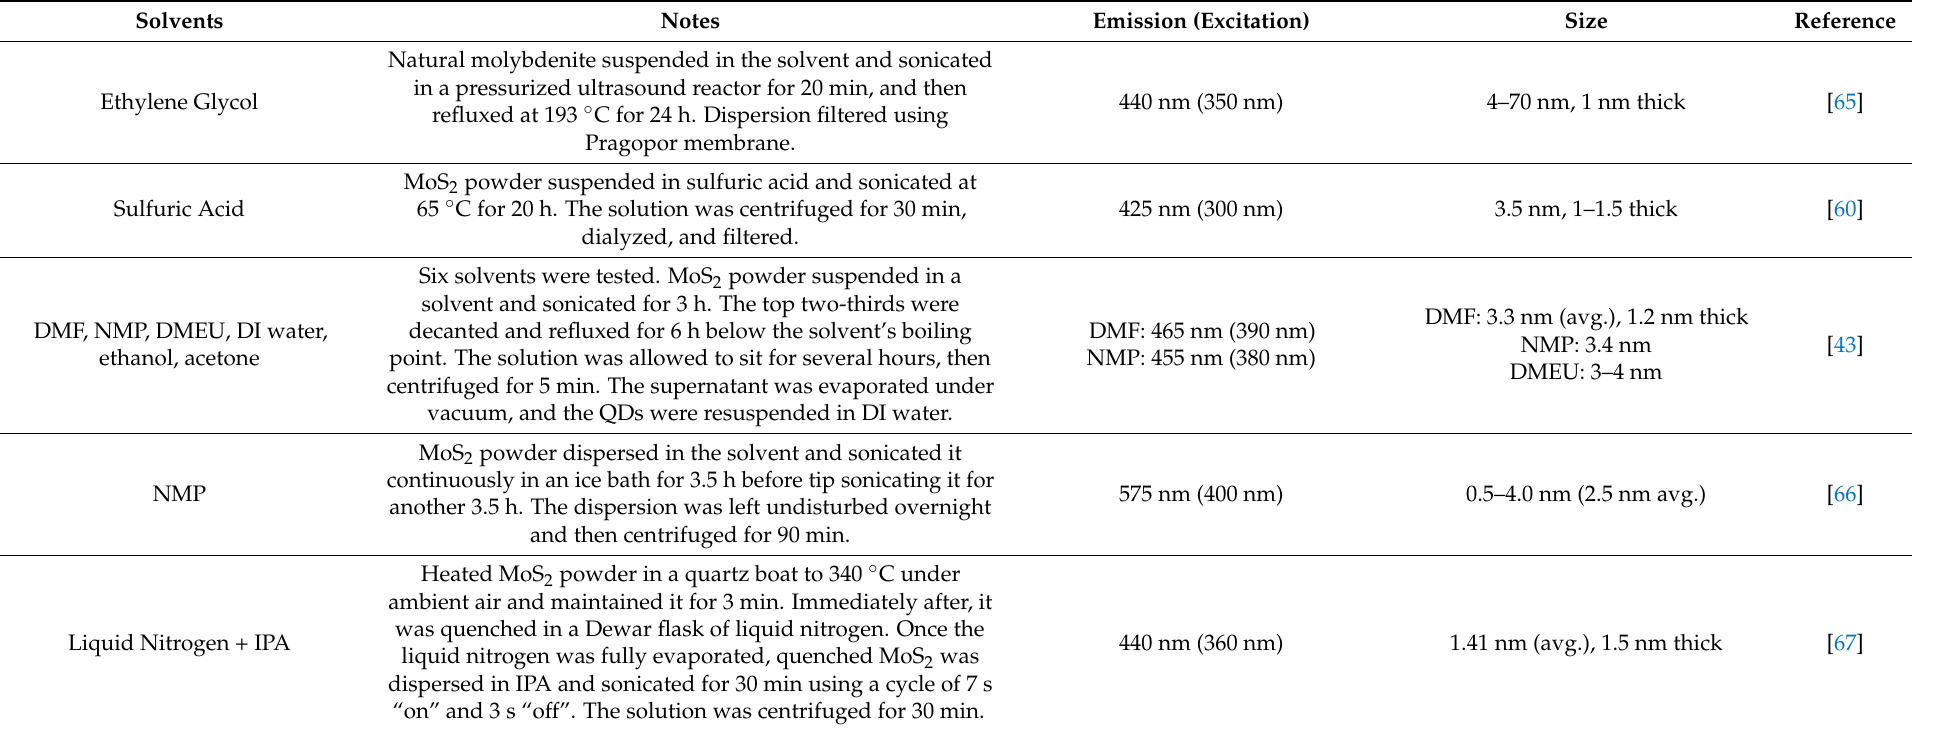
Table 1. Methods of sonication-assisted synthesis of MoS 2 QDs and experimental